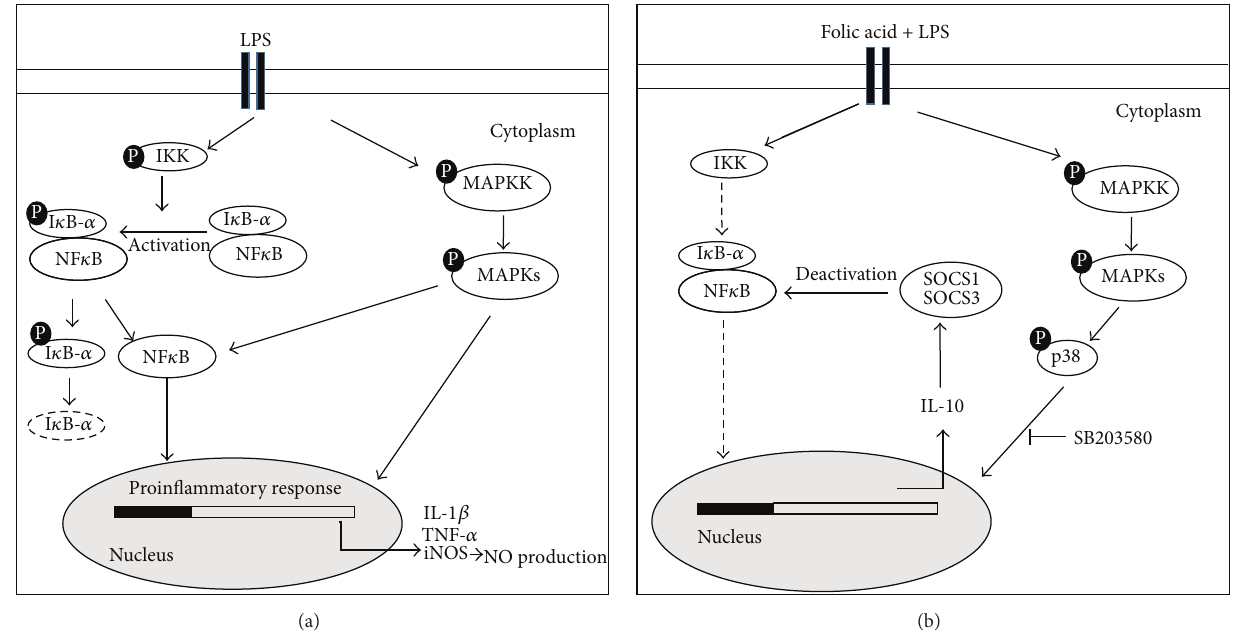
Figure 7: Schematic representation of a probable signaling pathway of folic acid mediated modulation of inflammatory response in microglia cells. (a) LPS activated BV-2 cells increases the expression of proinflammatory cytokines by MAPK phosphorylation and NF- 𝜅 B activation. The phosphorylation of IKK induces proteasomal degradation of I 𝜅 B- 𝛼 , enabling the active form of NF- 𝜅 B to translocate into the nucleus and induce IL-1 𝛽 , TNF- 𝛼 , and iNOS expression. Alternatively, NF- 𝜅 B is also activated by MAPK phosphorylation triggered by LPS treatment. (b) The folic acid pretreatment of LPS stimulated cells induces p38 MAPK phosphorylation leading to the upregulation of IL-10 production, selectively reduced in presence of p38 pharmacological inhibitor SB203580. IL-10 overproduction increases SOCS expression. Finally, SOCS proteins bind NF- 𝜅 B and suppress its